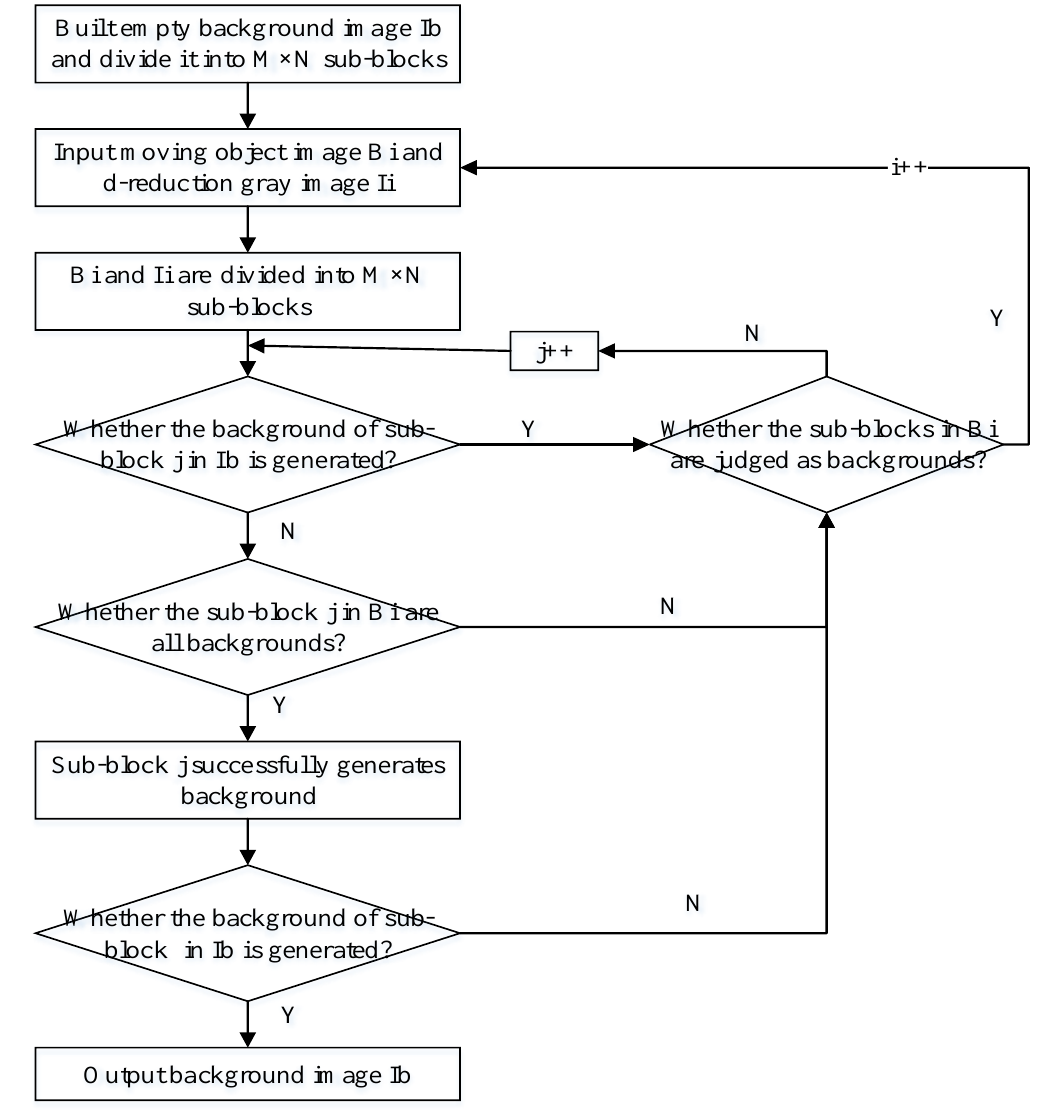
Figure 3. Background Modeling